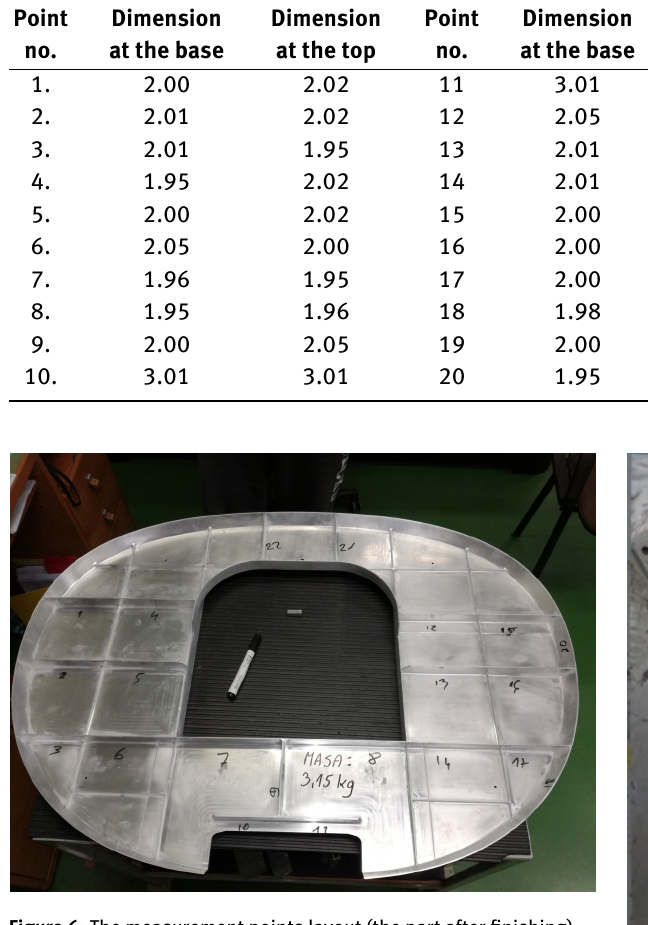
Figure 6: The measurement points layout (the part after finishing)